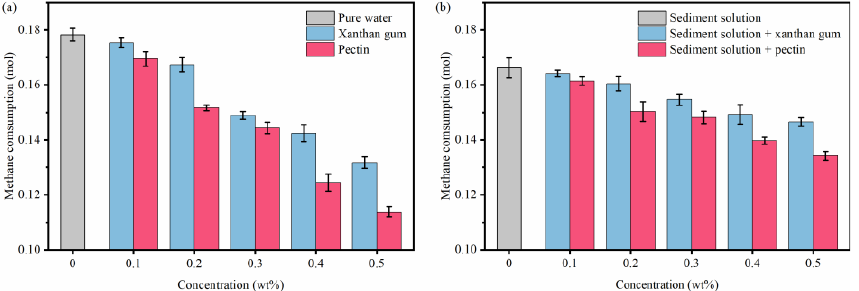
Figure 5. Effects of xanthan gum and pectin on the number of formed hydrates: ( a ) pure water systems; ( b ) sediment solution systems.